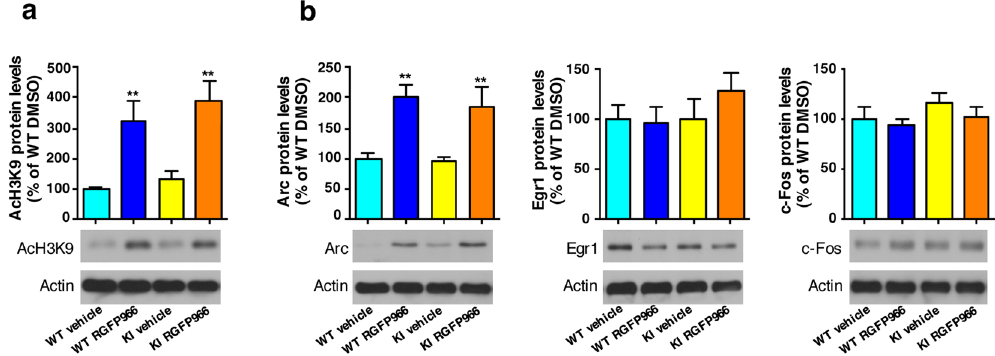
Figure 4. RGFP966 treatment induces Arc but not Egr1 or c-Fos protein levels in primary hippocampal cultures. (a ) Representative immunoblots showing histone H3 acetylation levels at position lysine 9 (AcH3K9) with actin as loading control and (b) Arc, Egr1 and c-Fos protein levels normalized to actin levels in DMSO and RGFP966 treated primary hippocampal cultures obtained from Hdh Q7/Q7 (WT) and Hdh Q7/Q111 (KI) embryos. The blots in (a and b) are cropped; full-length images are provided in Supplementary Figure 3. ** p < 0.01 compared to DMSO-treated cultures by two-way ANOVA with Bonferroni post-hoc analysis. Data represent the mean ± SEM (n = 4–5 cultures per